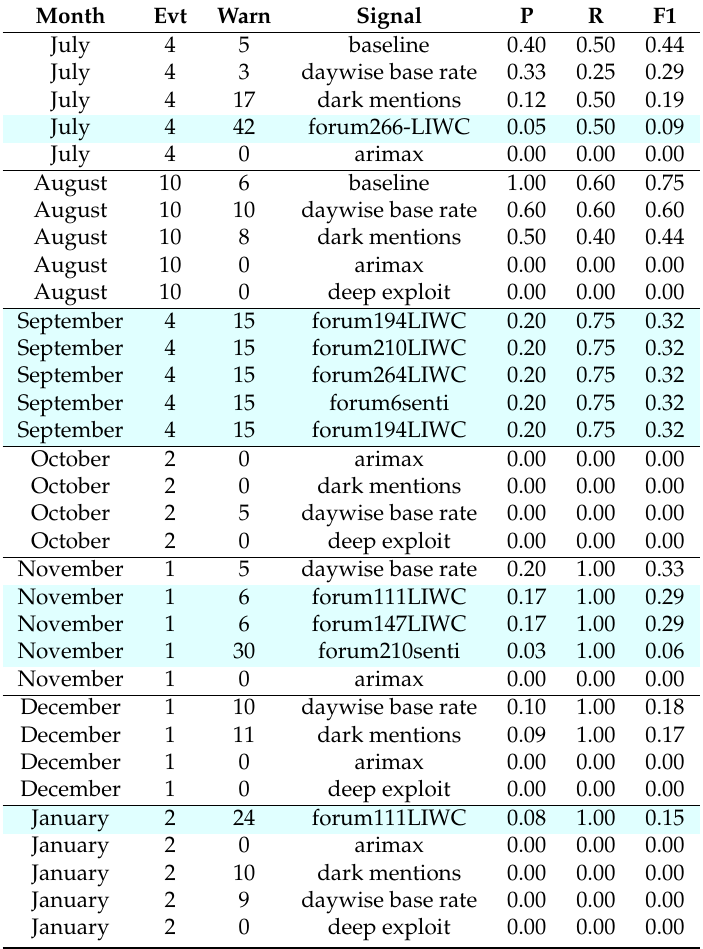
Table A2. Results from Org. A’s Malicious Destination.